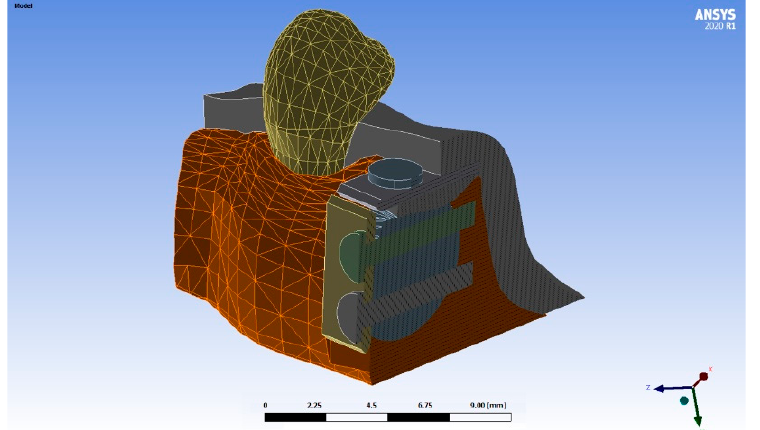
Figure 2. Simulation of a thin bone block with right-angled edges edges (different colors are used to distinguish different parts of the model).